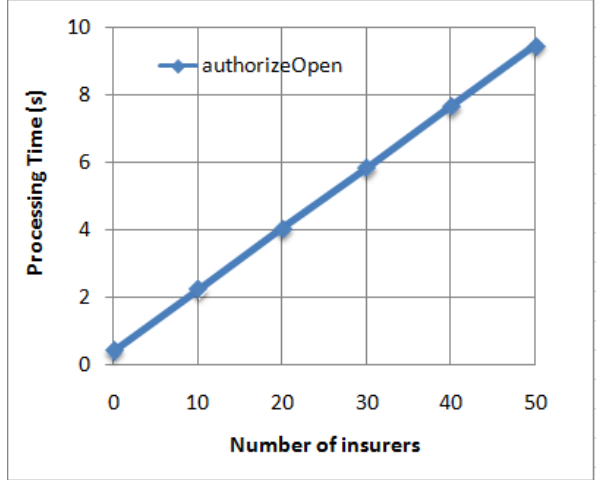
Figure 6. Computational cost for claim authorization by 50